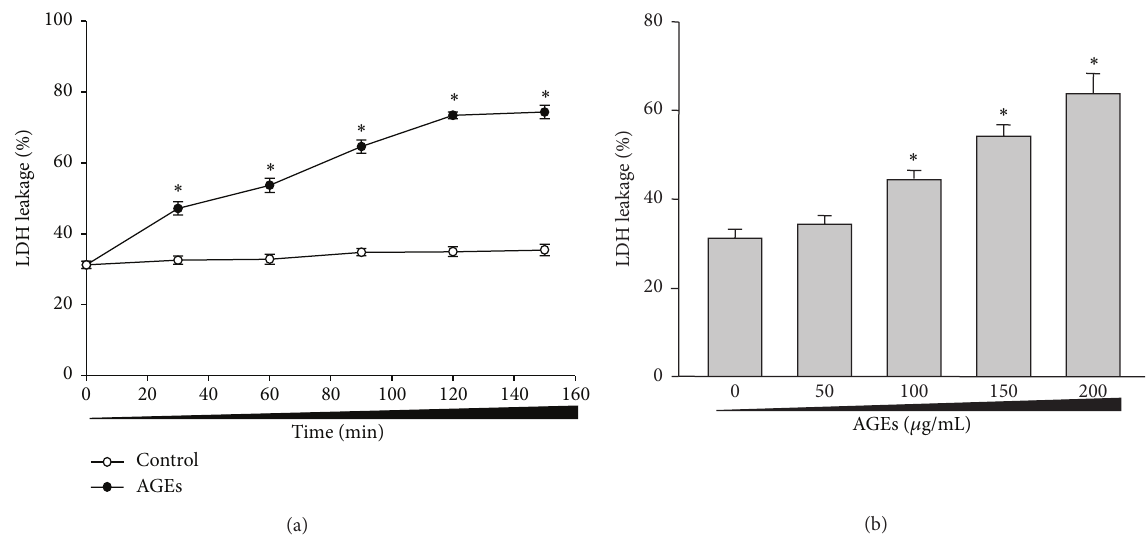
Figure 1: AGEs time-/dose-dependently increase LDH leakage in isolated renal cortex from rats. Cortex from isolated rat kidney was sliced into small pieces with the thickness of 0.3–0.5 mm. The slice was incubated with AGEs as indicated times and concentrations. LDH leakage was assayed in slice of renal cortex. (a) Time course of AGEs on LDH leakage. (b) Dose course of AGEs on LDH leakage. All data were expressed as mean ± SD. 𝑁 is 5 in each group. ∗ 𝑃 < 0.05 versus control